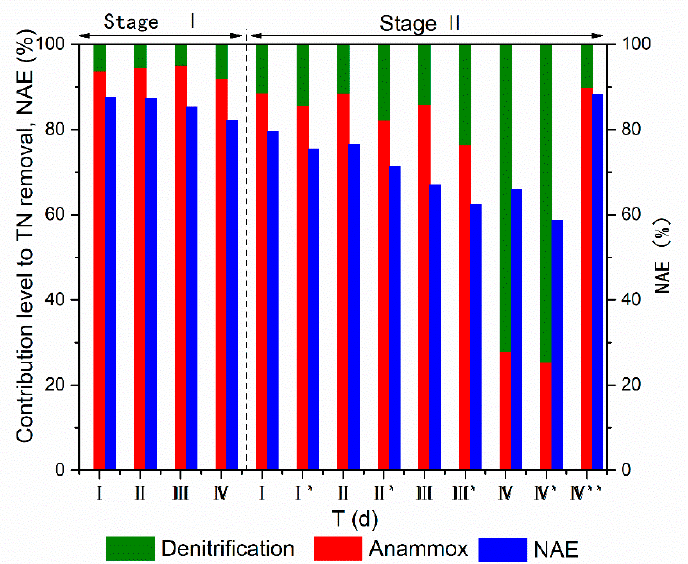
Figure 4. Nitrite accumulation efficiency (NAE) and contribution rate of anammox and denitrification to total nitrogen (TN) removal.